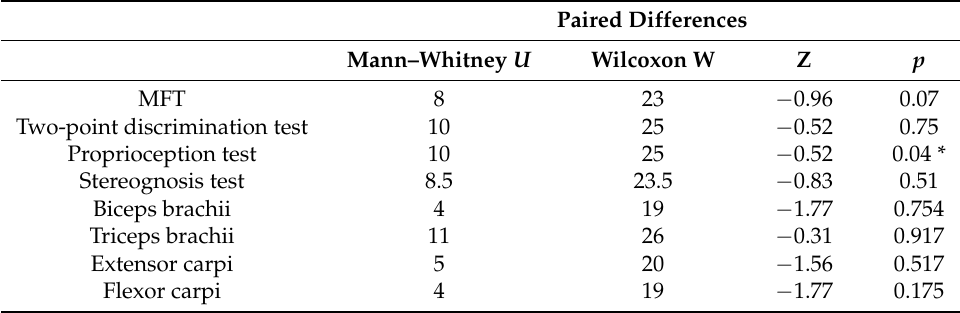
Table 3. Intergroup Mann–Whitney U Test.